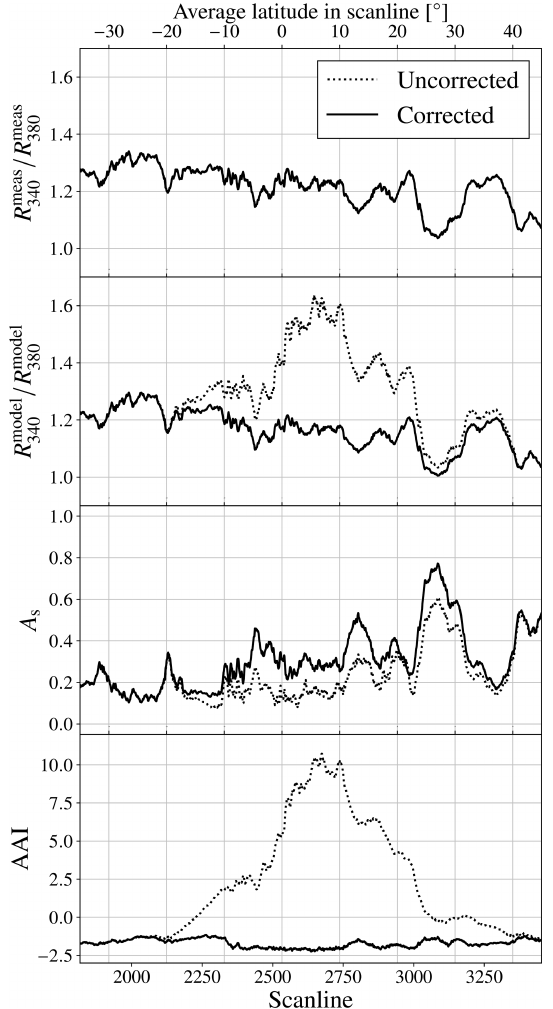
Figure 17. The scan line averages of (from top to bottom) R meas /R meas /R model , R model , A s , and AAI in orbit 11404, 26 De- 340 380 340 380 cember 2019. The average latitudes in the scan lines are indicated at the top. The dotted lines are the results before the solar irradi- ance correction, and the solid lines are the results after the solar irradiance correction. The lines for the uncorrected and corrected R meas /R meas overlap. 340 380